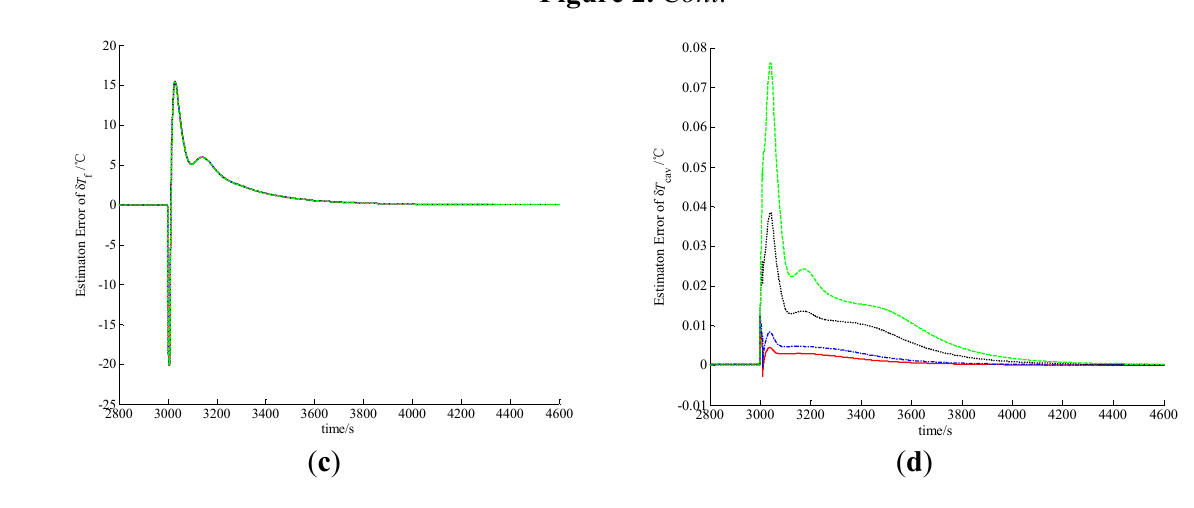
Figure 3. Observation errors of ( a ) δ n